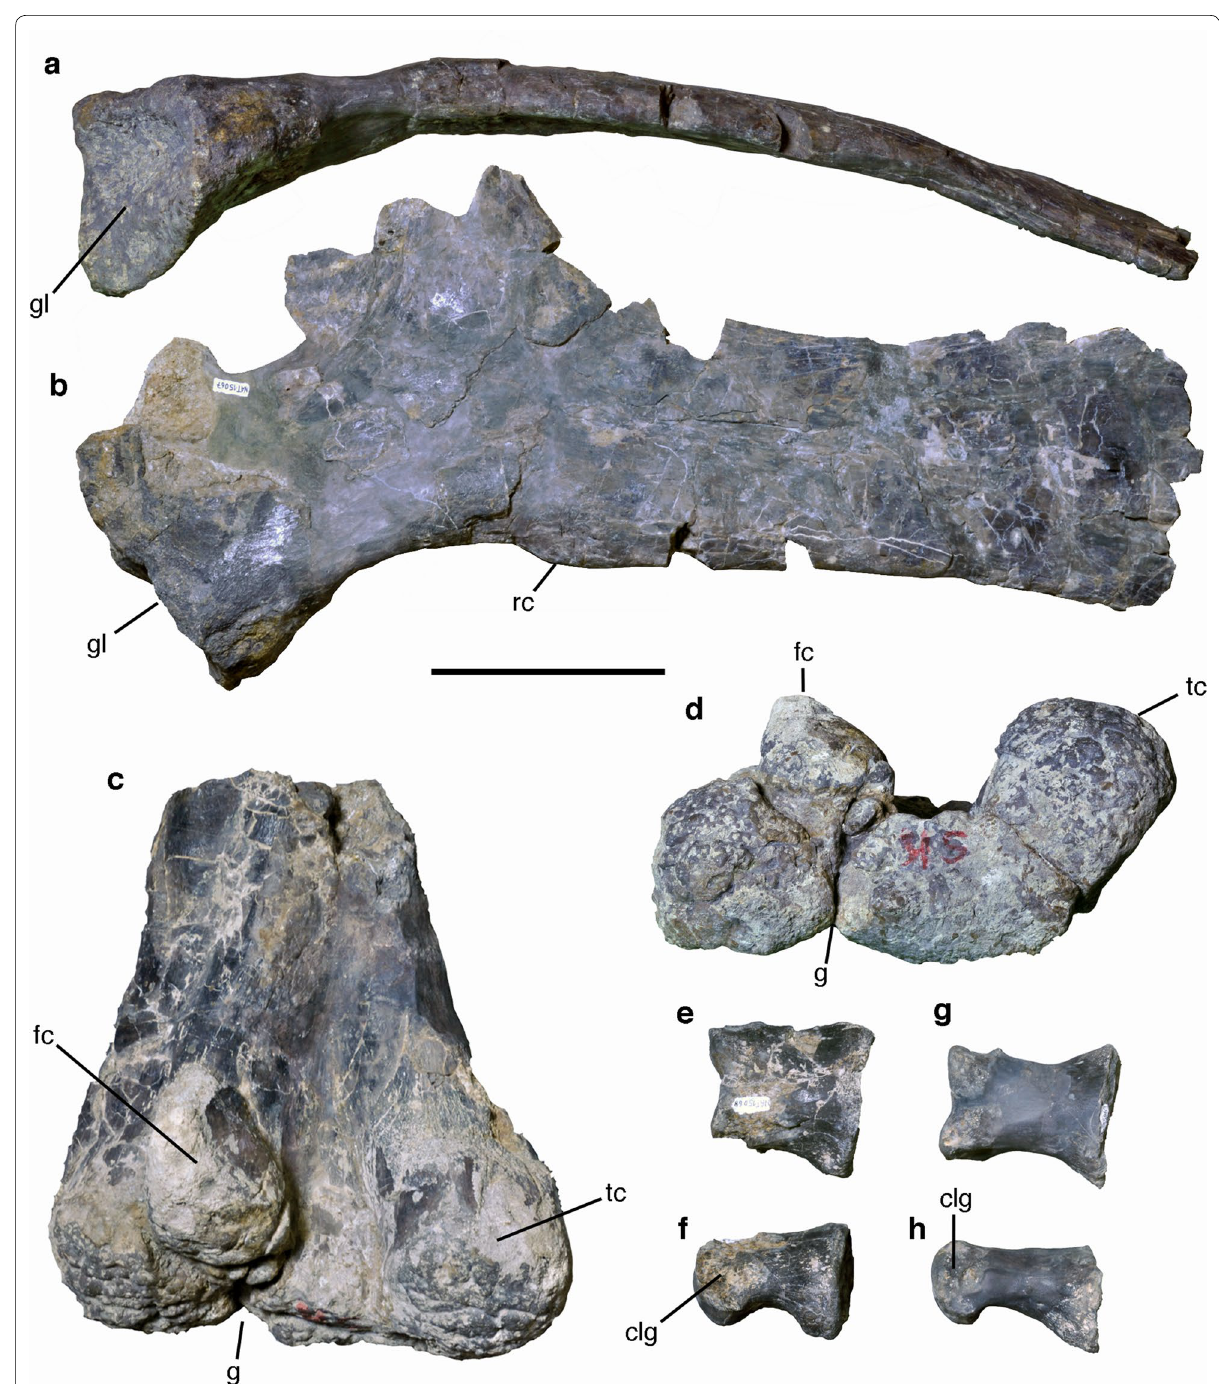
Fig. 17 Sauropodomorph material from Hallau-Schwärzibuck. a , b Left scapula, MzA NAT15067, in ventral ( a ) and lateral ( b ) view; c, d distal end of left femur, MzA NAT15065, in posterior ( c ) and distal ( d ) view; e , f pedal phalanx, MzA NAT15068, in dorsal ( e ) and lateral ( f ) view; g , h pedal phalanx, MzA NAT15069, in dorsal ( e ) and lateral ( f ) view. clg, collateral ligament groove; fc, fibular condyle; g, groove; gl, glenoid; rc, rugose convexity; tc, tibial condyle. Scale bar equals 10